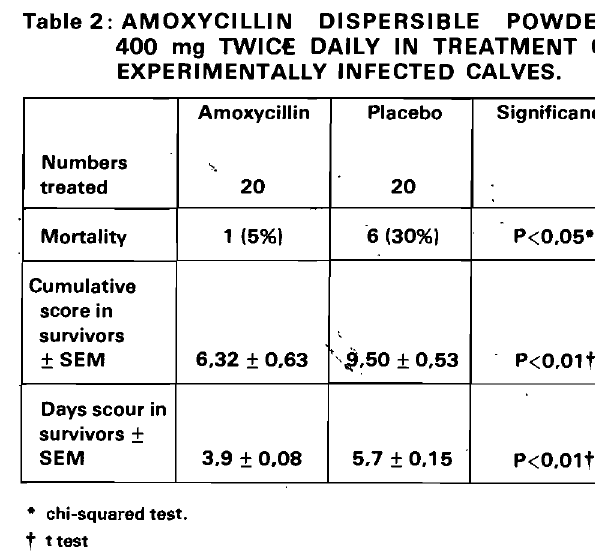
Table 2: AMOXYCILLIN DISPERSIBLE POWDER. 400 mg TWICE DAILY IN TREATMENT OF EXPERIMENTALLY INFECTED